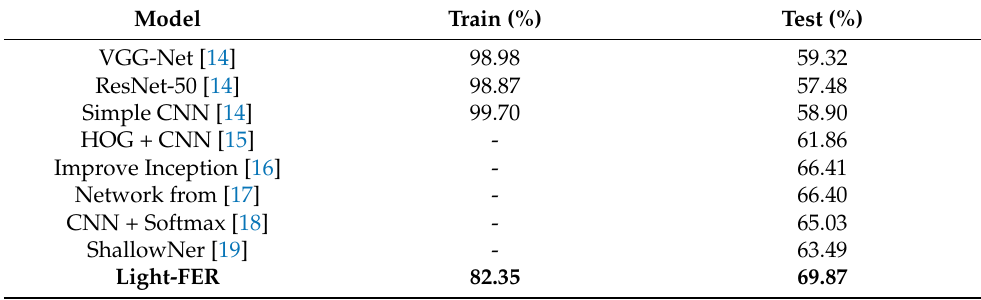
Table 2. Comparison of different FER models based on training and test accuracy results.